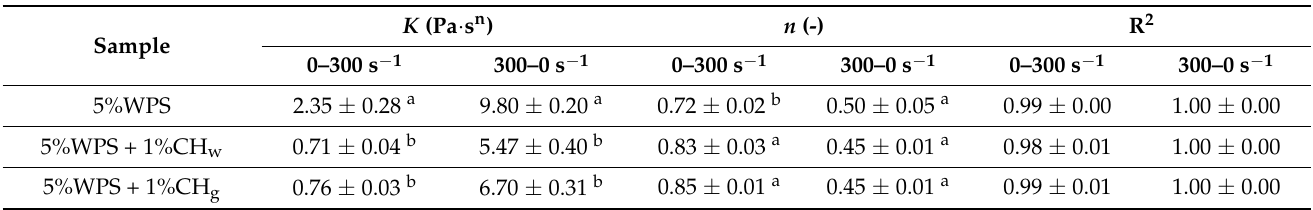
Table 4. Parameters of steady flow measurements (Ostwald–de Waele model) of 5% WPS and its mixtures with 1% CH (whole and ground